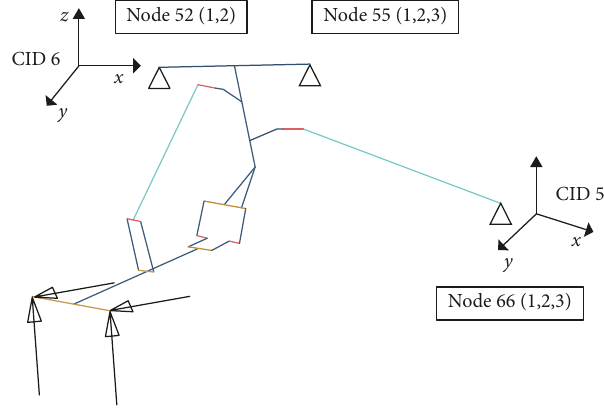
Figure 3: Stick model of the landing gear.